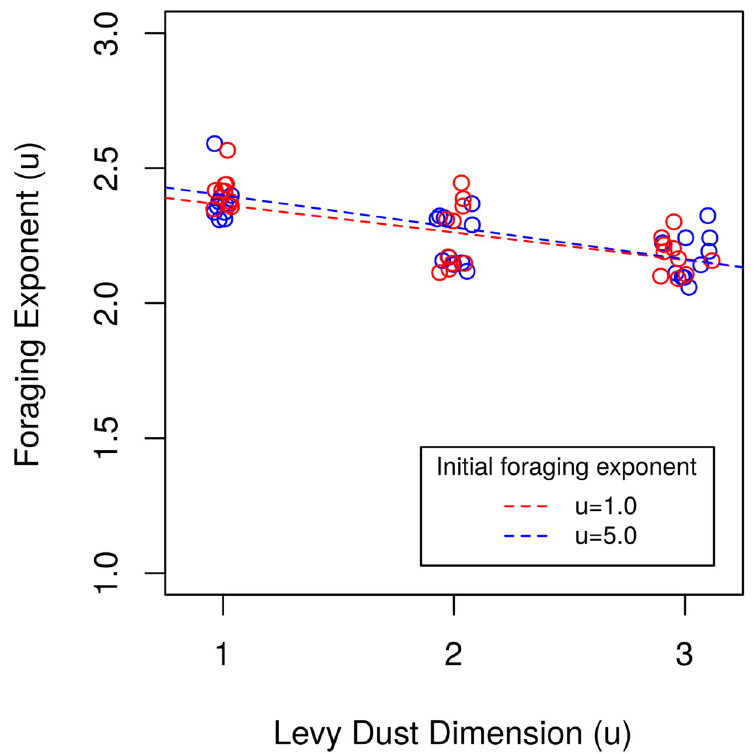
Fig 12. Testing the extrinsic hypothesis. Determining whether the evolved foraging exponents from simulations with K = 1500, χ = 0, and σ sv = (0.25, 0.5) positively correlate with the Le´vy dust dimension. Simulations of populations with an initial mean foraging exponent of u = 1.0 are marked with red circles, u = 5.0 with blue circles, and their trends are marked with a colour corresponding dashed line; u = 1.0: r = − 0.70 ( P < 0.05, t ( P < 0.05, t df =28 = − 5.9). Note: jitter was added to the x-axis to help differentiate points.